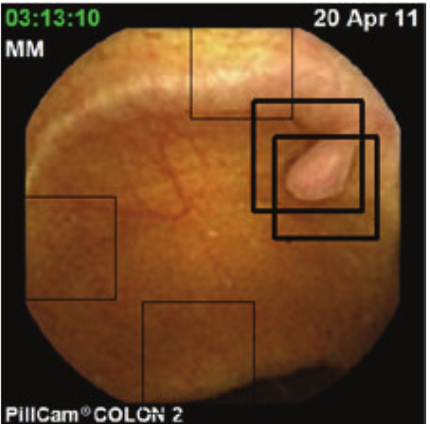
Figure 4: Detection and recognition of a polyp area using the approach proposed in [2] on WCE images. It can be noticed that the only 5-bit resolution of the cooccurrence matrices used for the learning step of the algorithm avoids being too dependent on the “quality” of the